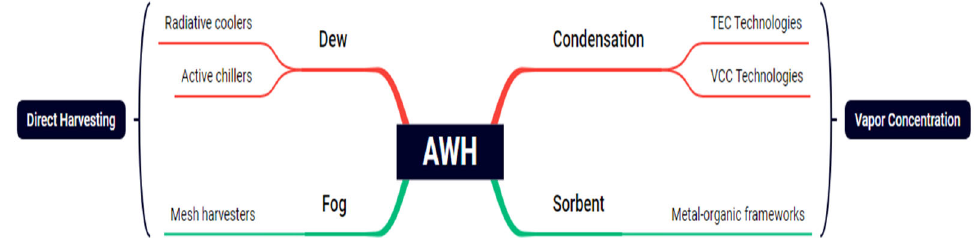
Figure 1. Different methods of AWH systems and process categories [20–22].